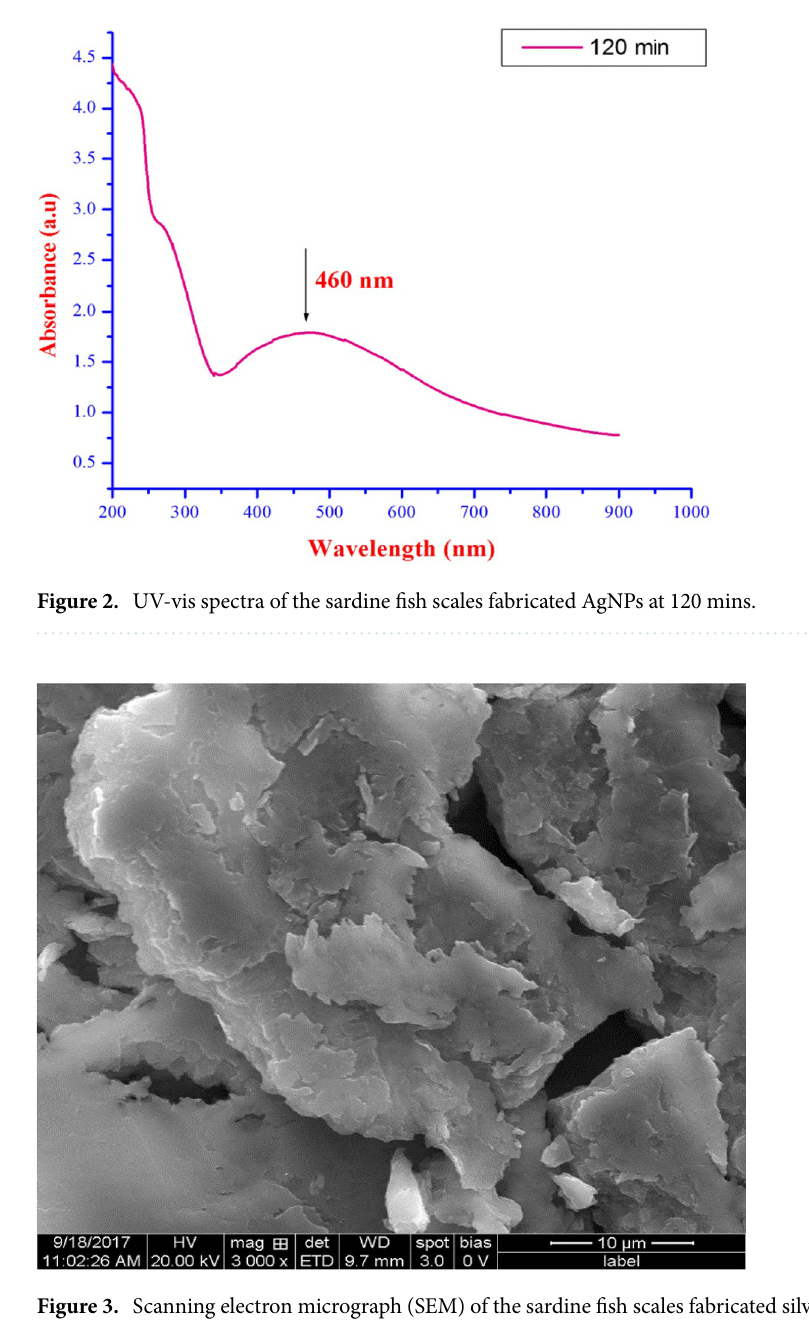
Figure 3. Scanning electron micrograph (SEM) of the sardine fish scales fabricated silver